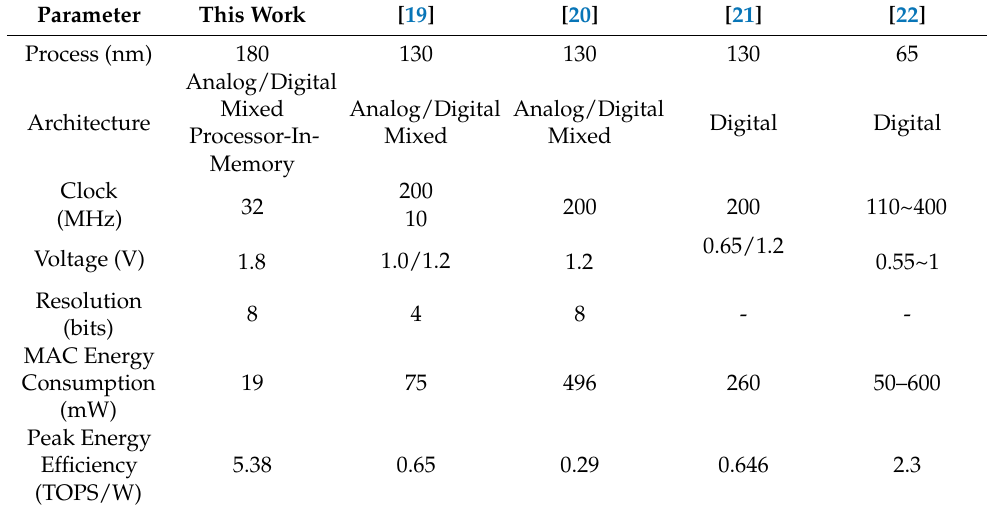
Table 1. Performance